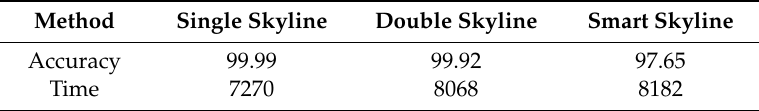
Table 11. SKY–SVM on the synthetic Dataset